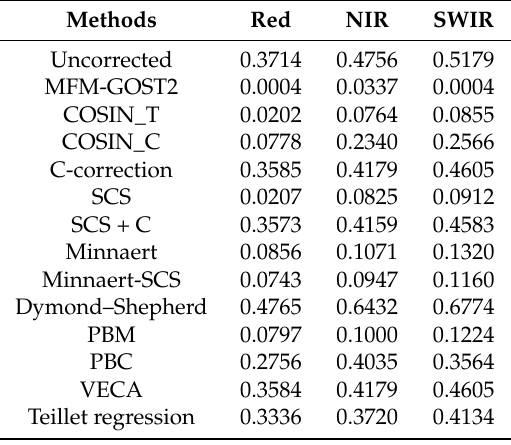
Table 3. R 2 between the cosine of the incident angle and the corrected/uncorrected radiances in the red, NIR and SWIR bands,